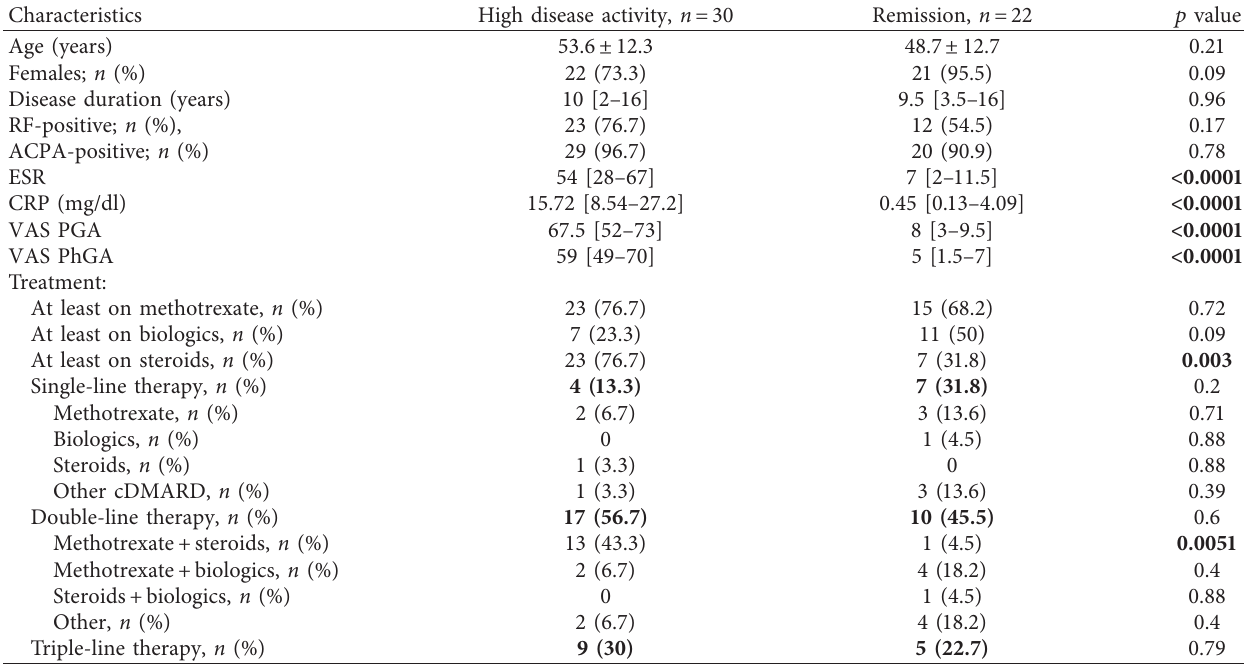
Table 3: Characteristics of patients with rheumatoid arthritis included in the methylation analysis.